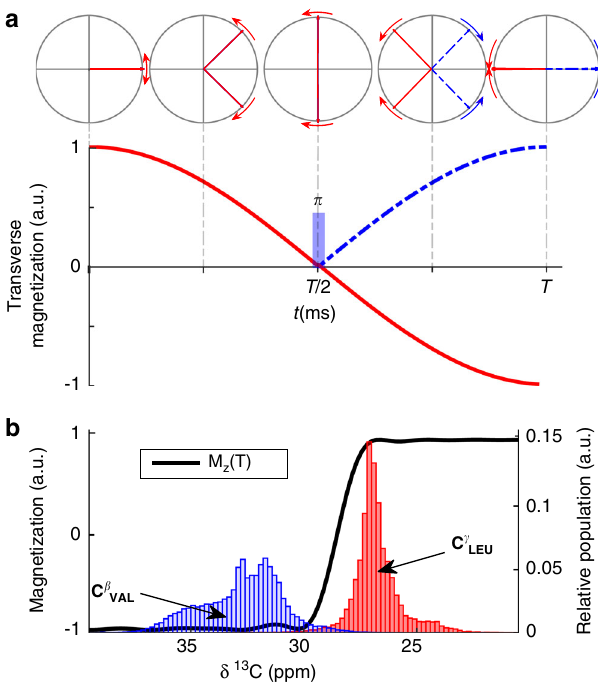
Fig. 1 Theory of decoupling using selective inversion to distinguish leucine from valine. a Trajectory of the 13 CH 3 leucine (red) and valine (blue, dashed) magnetization during a constant time encoding period of duration T = 1 / 1 J CC = 28 ms. Selective decoupling of valine at time T/ 2 refocuses the coupling and produces positive peaks for valine at time T . Leucine is not decoupled, and the coupling interaction leads to negative peaks at time T . b The distributions of C β and C γ chemical shifts of valine (blue) and leucine (red) are distinct. Assuming an initial state of I z , our decoupling pulse selectively inverts the C β Val , which selectively decouples the valine methyl resonance. The encoding of the methyl-carbon chemical shift continues unaffected during the selective homonuclear decoupling